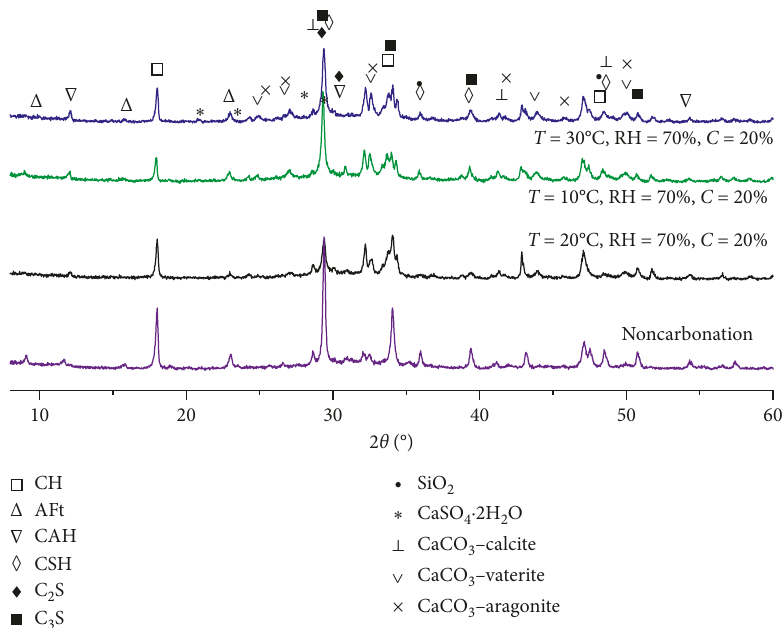
Figure 4: XRD spectrum of samples under different carbonation conditions.